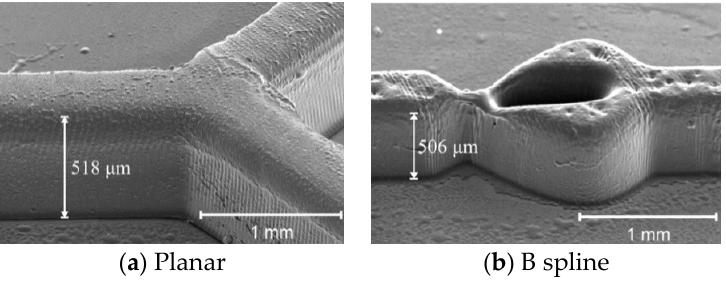
Figure 9. SEM images of 45° tilt angle of SU8 mould.